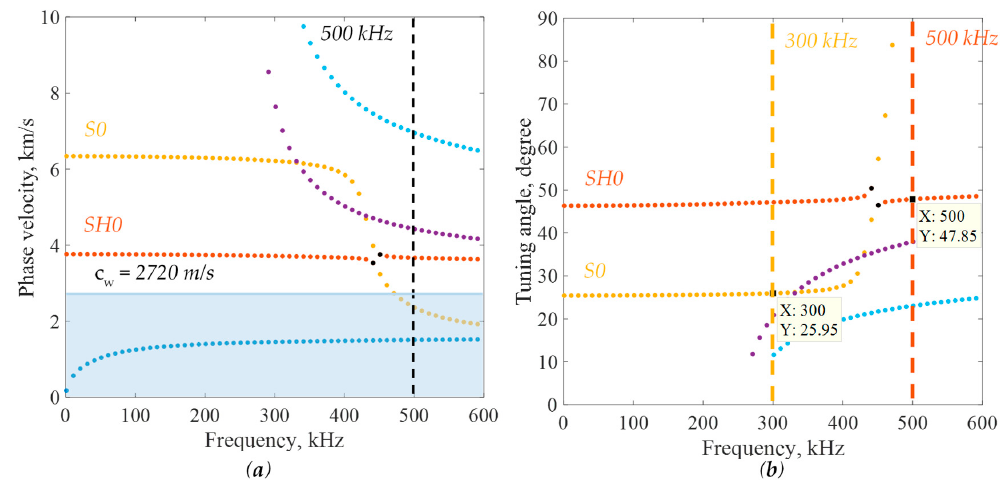
Figure 17. Dispersion curves of a 3-mm [ − 45 / 90 / 45 / 0] 3s quasi-isotropic composite plate: ( a ) phase velocity; ( b ) tuning angle.